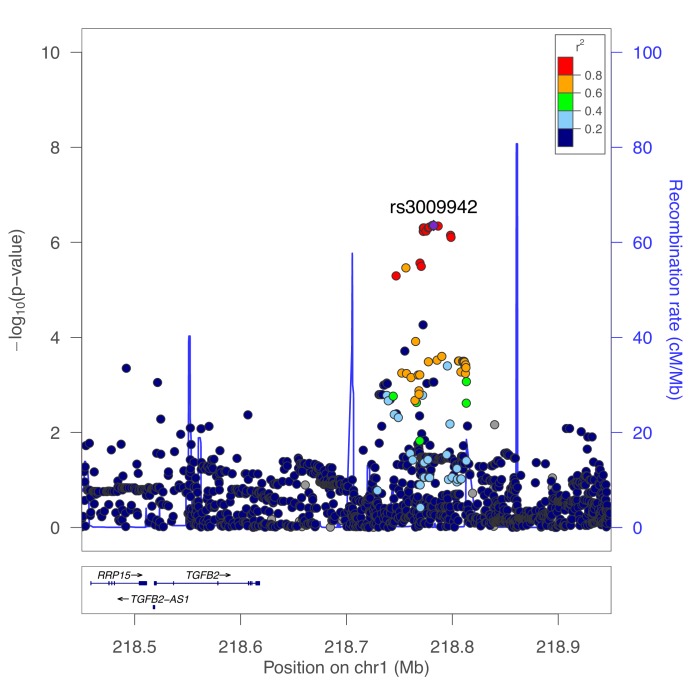
Secondary association for moderate centrilobular emphysema at the TGFB2 locus.Results from genetic association meta-analysis conditioned on the lead SNP (rs796395) at this region.